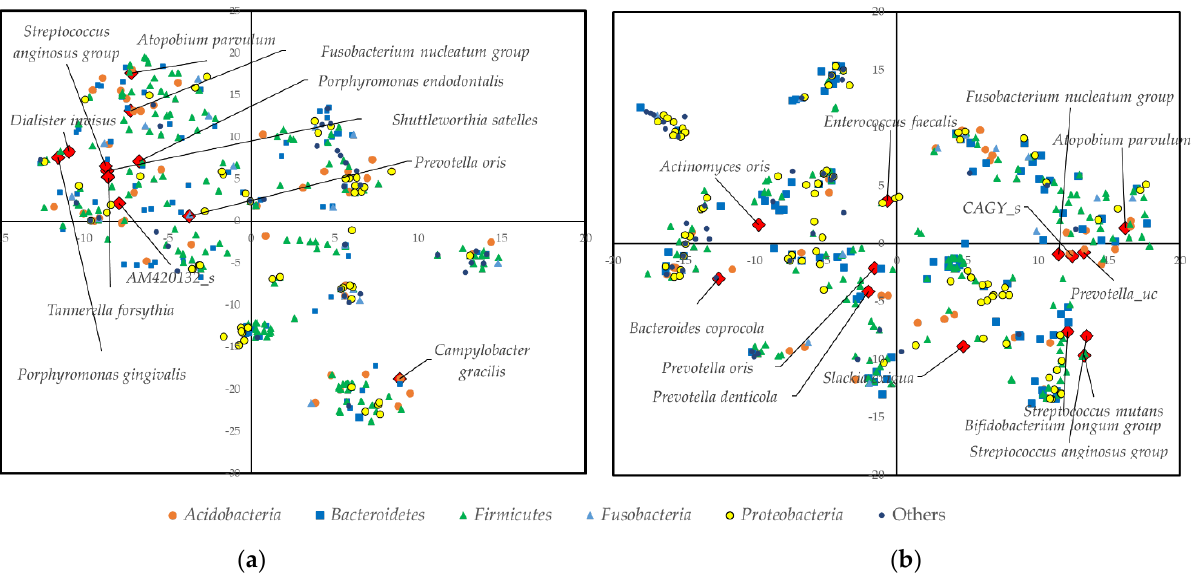
Figure 3. tSNE analysis of the oral microbiome; ( a ) Baseline; ( b ) Before cancer operation.